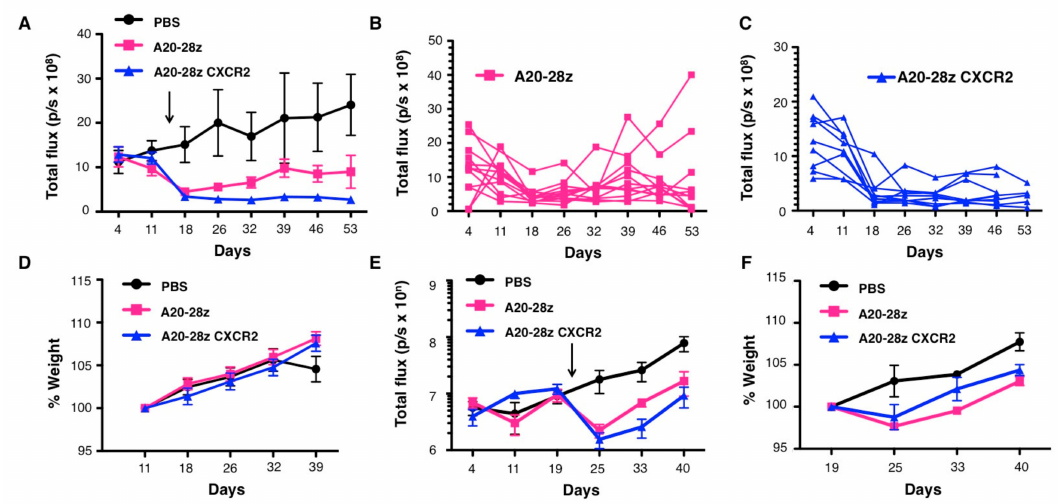
Figure 5. Improved therapeutic e ffi cacy of chemokine-responsive CAR T-cells in vivo. ( A ) Mice were injected using the intraperitoneal (IP) route with 2 × 10 6 Panc04.03-firefly luciferase cells and